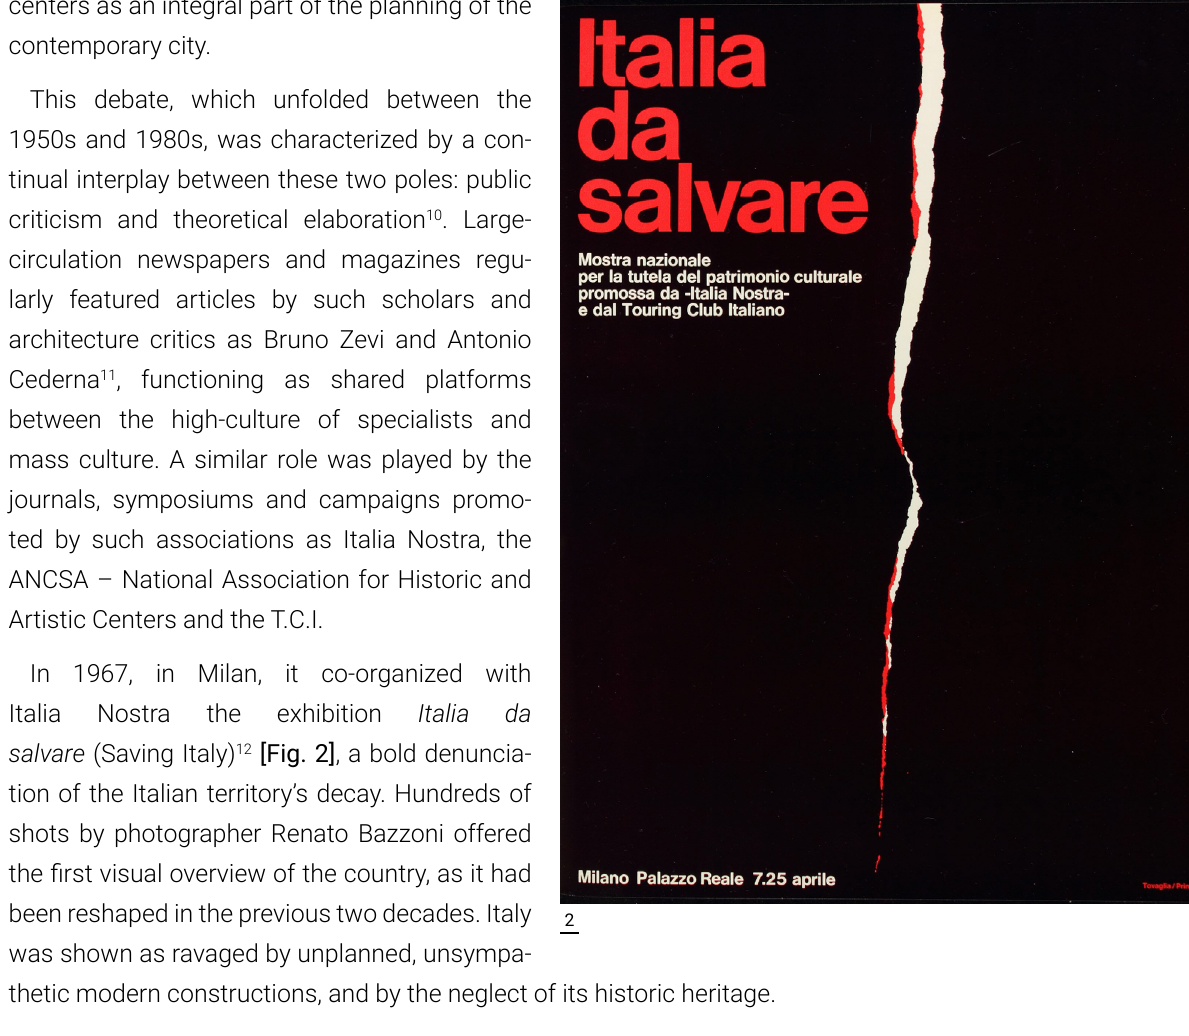
Fig. 2 The cover of Italia da Salvare , the exhibition organized by Italia Nostra and the T.C.I. at Milan’s Royal Palace in 1967. Cover design by Pino Tovaglia. Courtesy of the